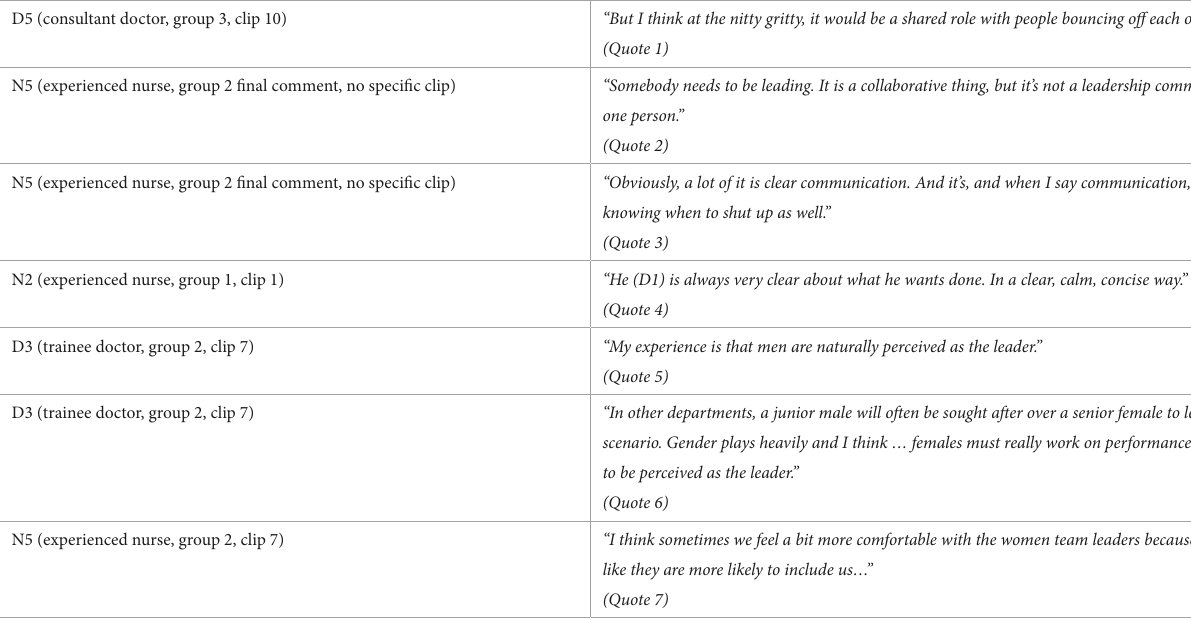
TABLE 4 Illustrative quotes (conceptualizations of